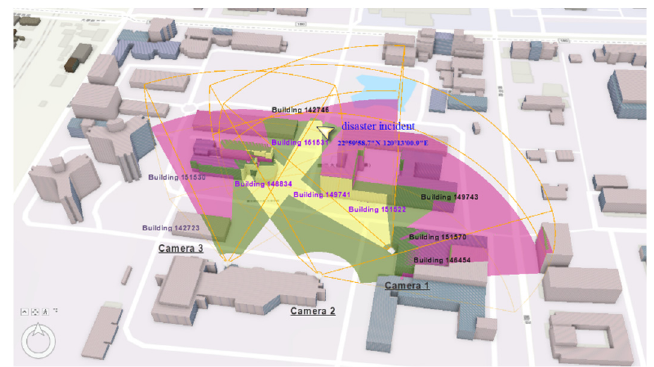
Figure 14. Using 2D FOV test to filter candidate CCTVs. (The Chinese on figure represents the Landmark name or road name.)